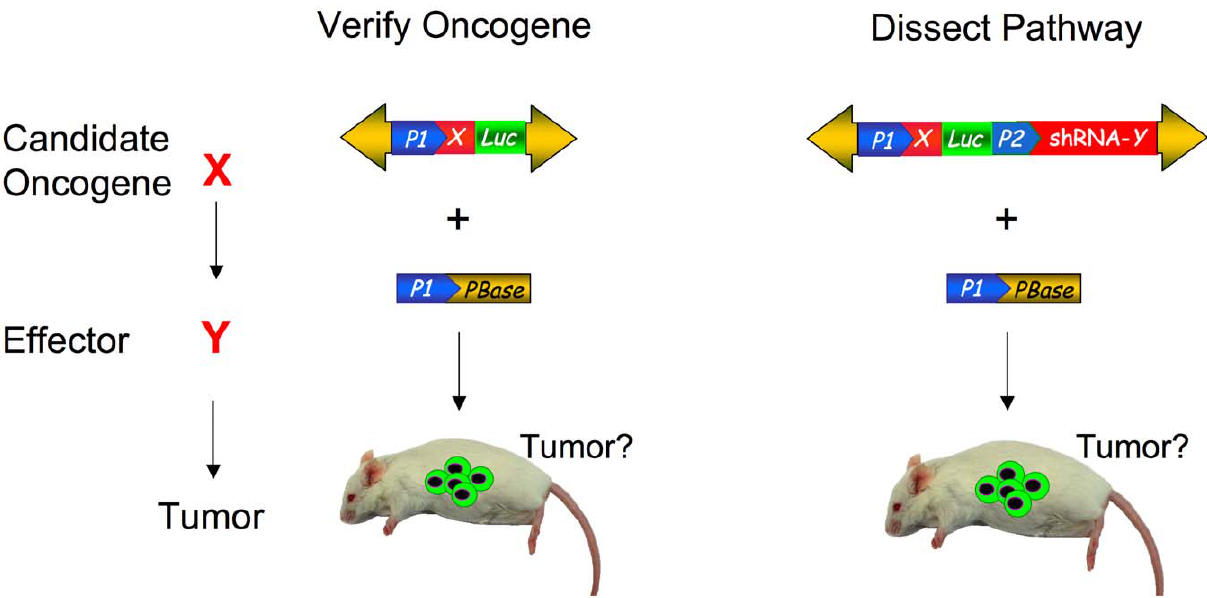
Figure 1. Somatic phenotypes like cancer can be modeled and genetically dissected with transposon mutagenesis. Potential oncogenic pathway to be interrogated with candidate oncogene X and effector Y in red (left). Depiction of PB transposon construct for verifying oncogene X (center). Yellow arrows detail transposon arms. Promoters are depicted by blue pointed boxes. Gene X is indicated by red box and luciferase marker is indicated by green box. To test if effector Y is involved in the oncogenic pathway, an shRNA cassette to knockdown gene Y is represented by the red box (right). The transposons are co-transfected or electroporated with PBase (lower yellow box) to stably integrate the transposon construct into the mouse cells. The green cells in the mouse indicate luciferase positive cells expressing the transposed construct, which are monitored for the tumor formation.